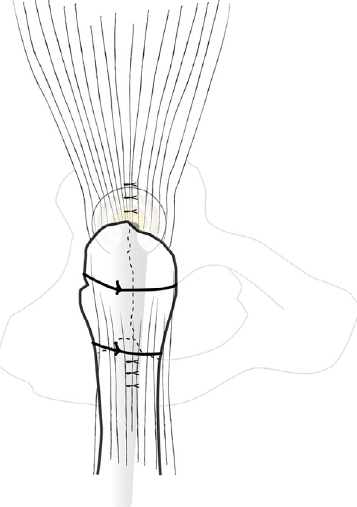
Figure 10. Great trochanter fixation after reattachment with two wires.